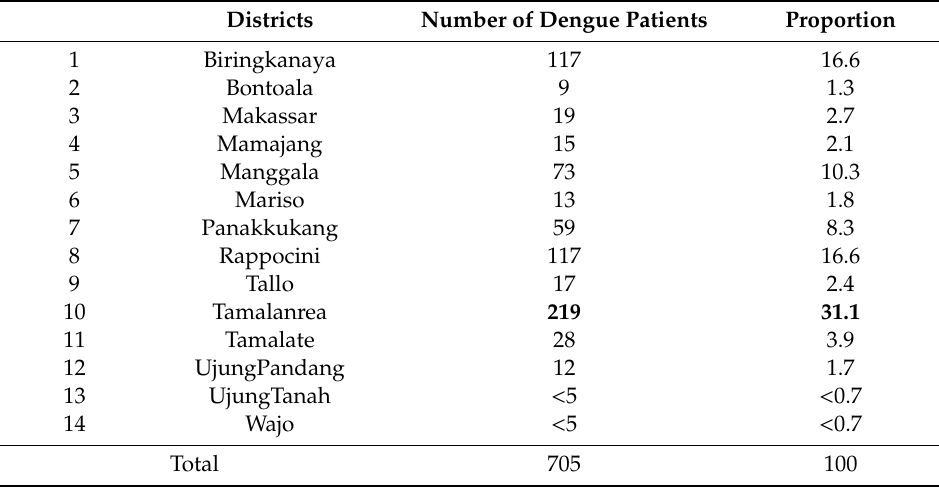
Table 1. The distribution of dengue patients admitted to Wahidin hospital in the study period by district of